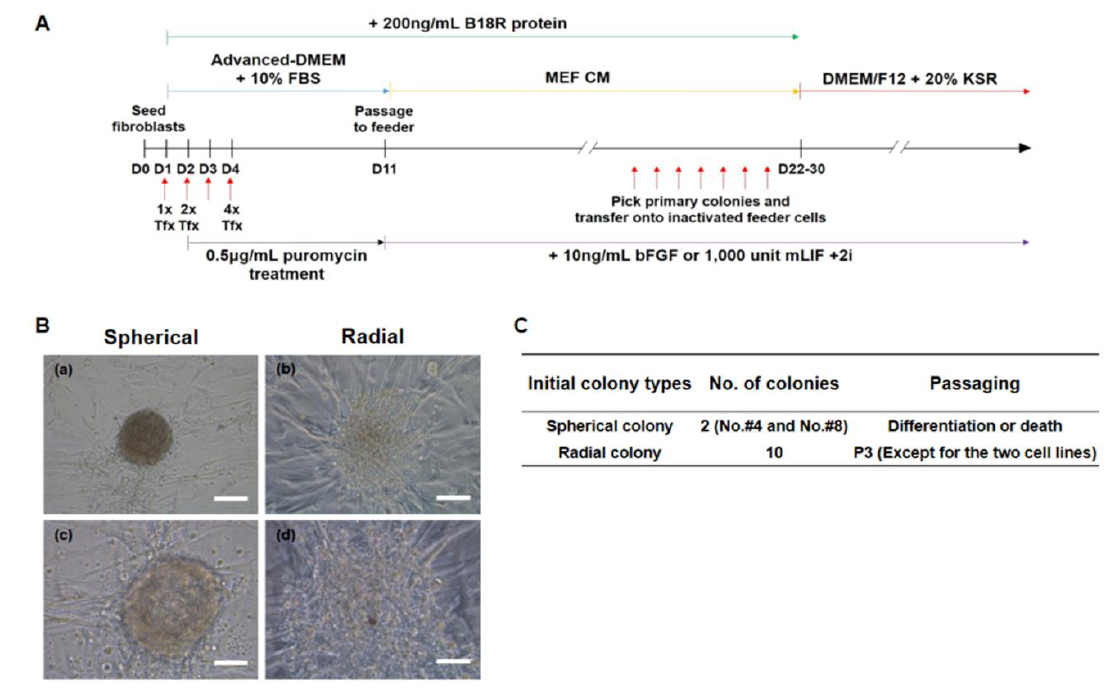
Figure 3. Two distinct types of initial canine induced pluripotent stem cell (ciPSC) colonies. ( A ) Timeline of synthetic mRNA-mediated reprogramming using a method of co-transfecting T7-VEE-OKS-iG and B18R mRNAs. ( B ) Representative images of the initial ciPSC colonies after introducing four reprogramming factors by VEE RNA on day 25. (a) and (c) Typical images of a spherical colony. (b) and (d) Typical images of a radial colony. Scale bars = 200 µ m for (a, b); 50 µ m for (c, d). ( C ) Information of the initial ciPSCs classified based on the colony morphology.